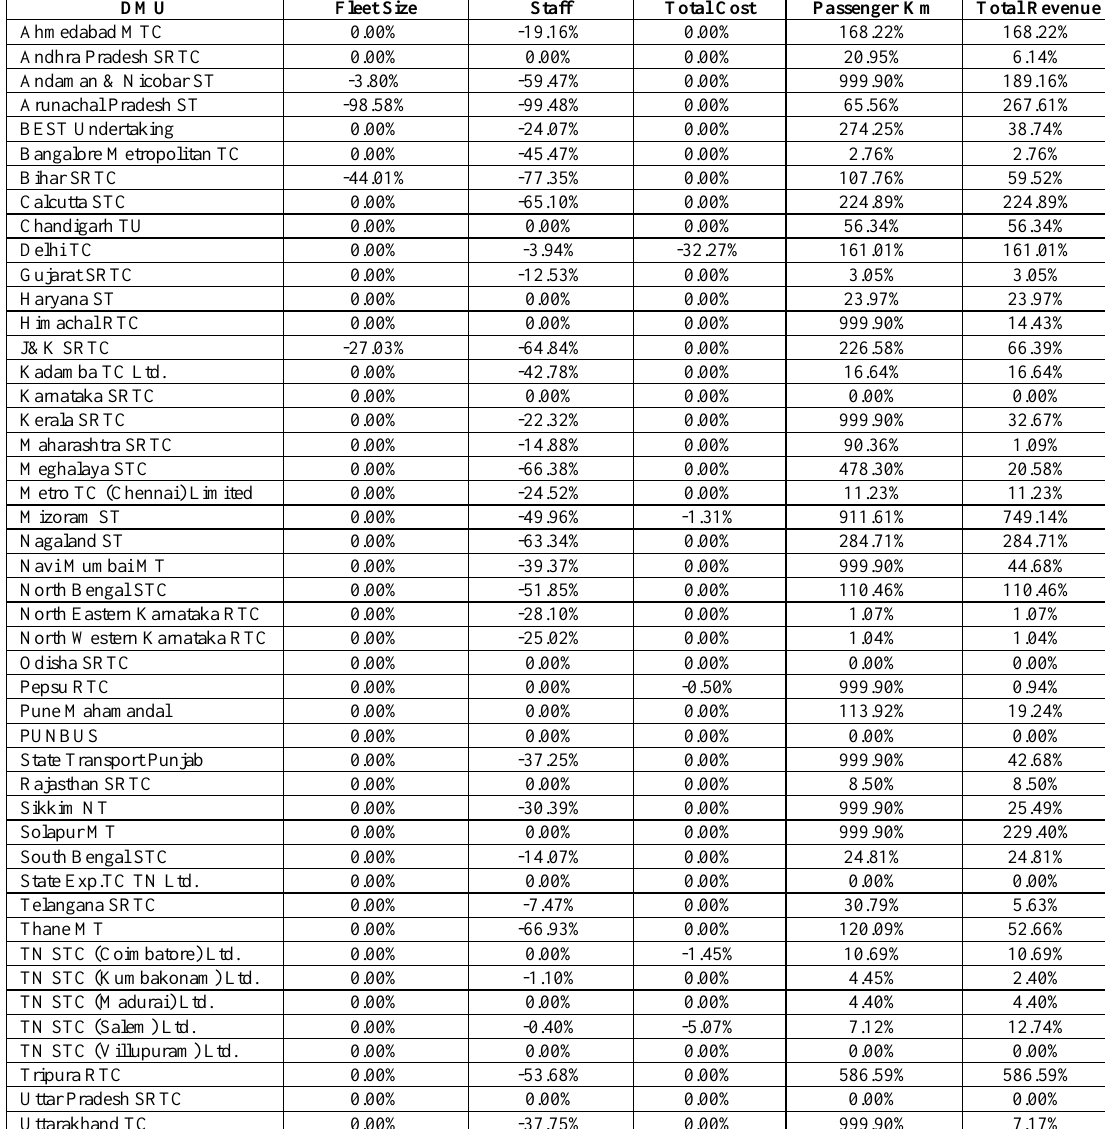
Table 4. Potential improvements (in